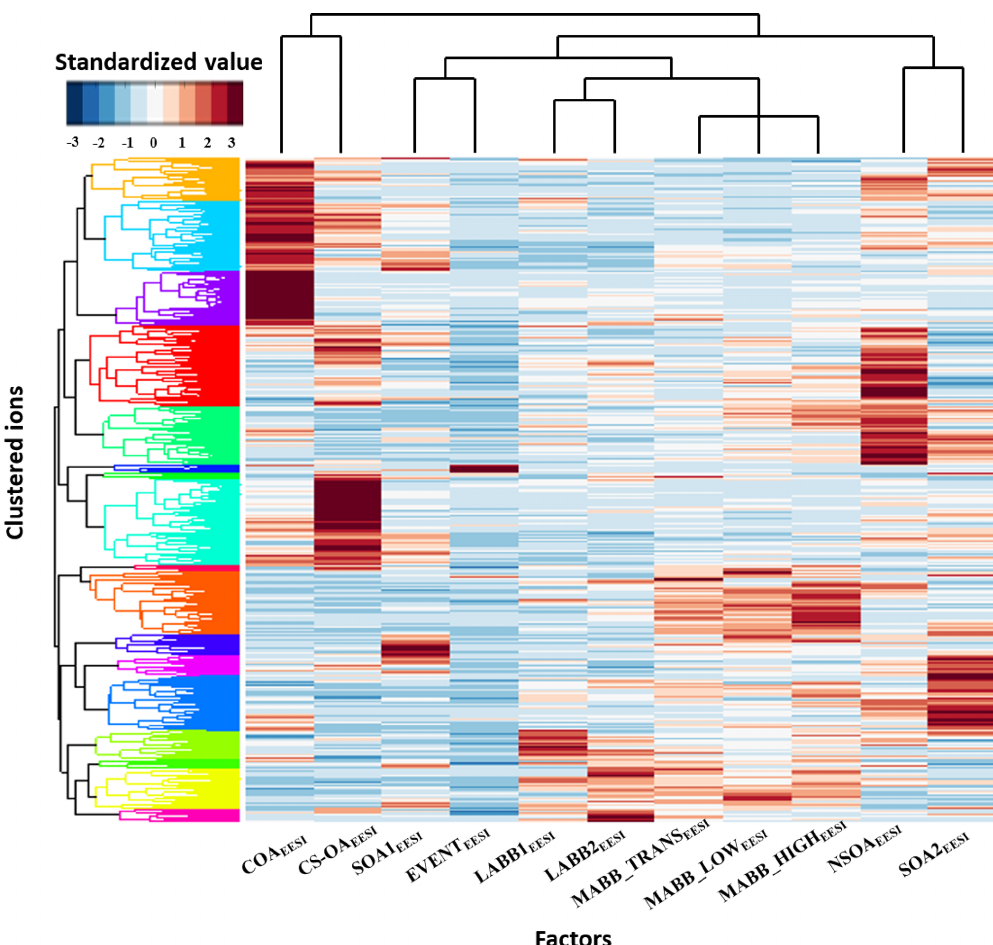
Figure 11. Standardized matrix of individual EESI-TOF-MS ions vs. EESI-TOF-MS PMF factors. Ions and factors are sorted according to the results of their respective hierarchical clustering analysis; the resulting dendrograms are shown on the respective axes. The color of the compounds’ groups in the dendrogram are chosen to make groupings convenient to read (color is